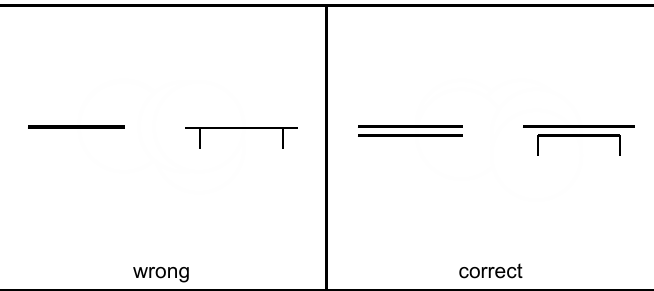
Figure 4.3: Edges must not overlap node borders.